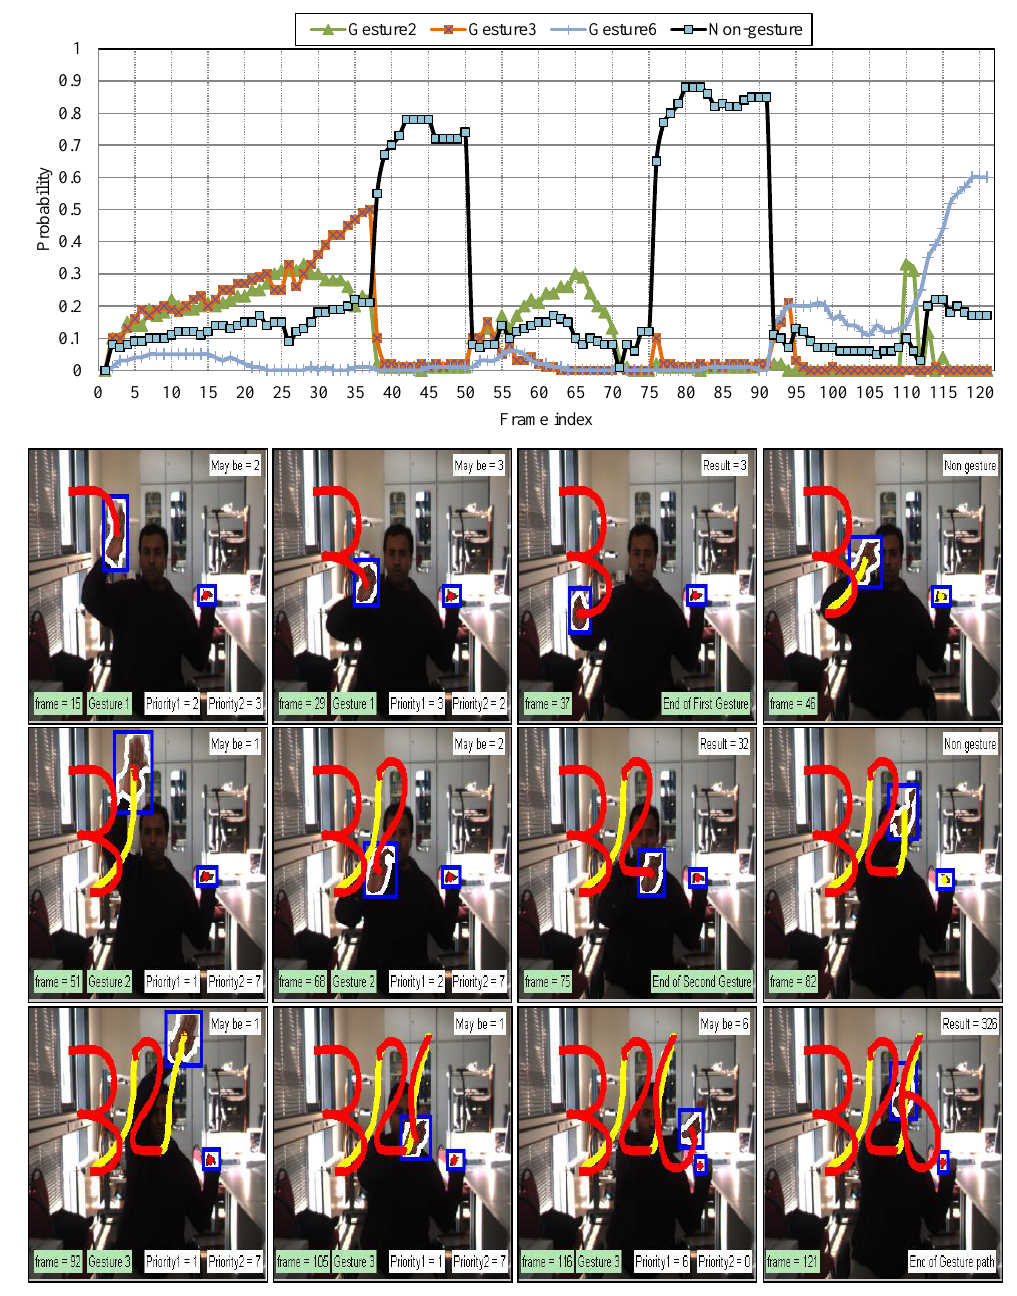
Figure 13. The progression of probability over time for the hand gestures “Gesture2”, “Gesture3”, “Gesture6”, and